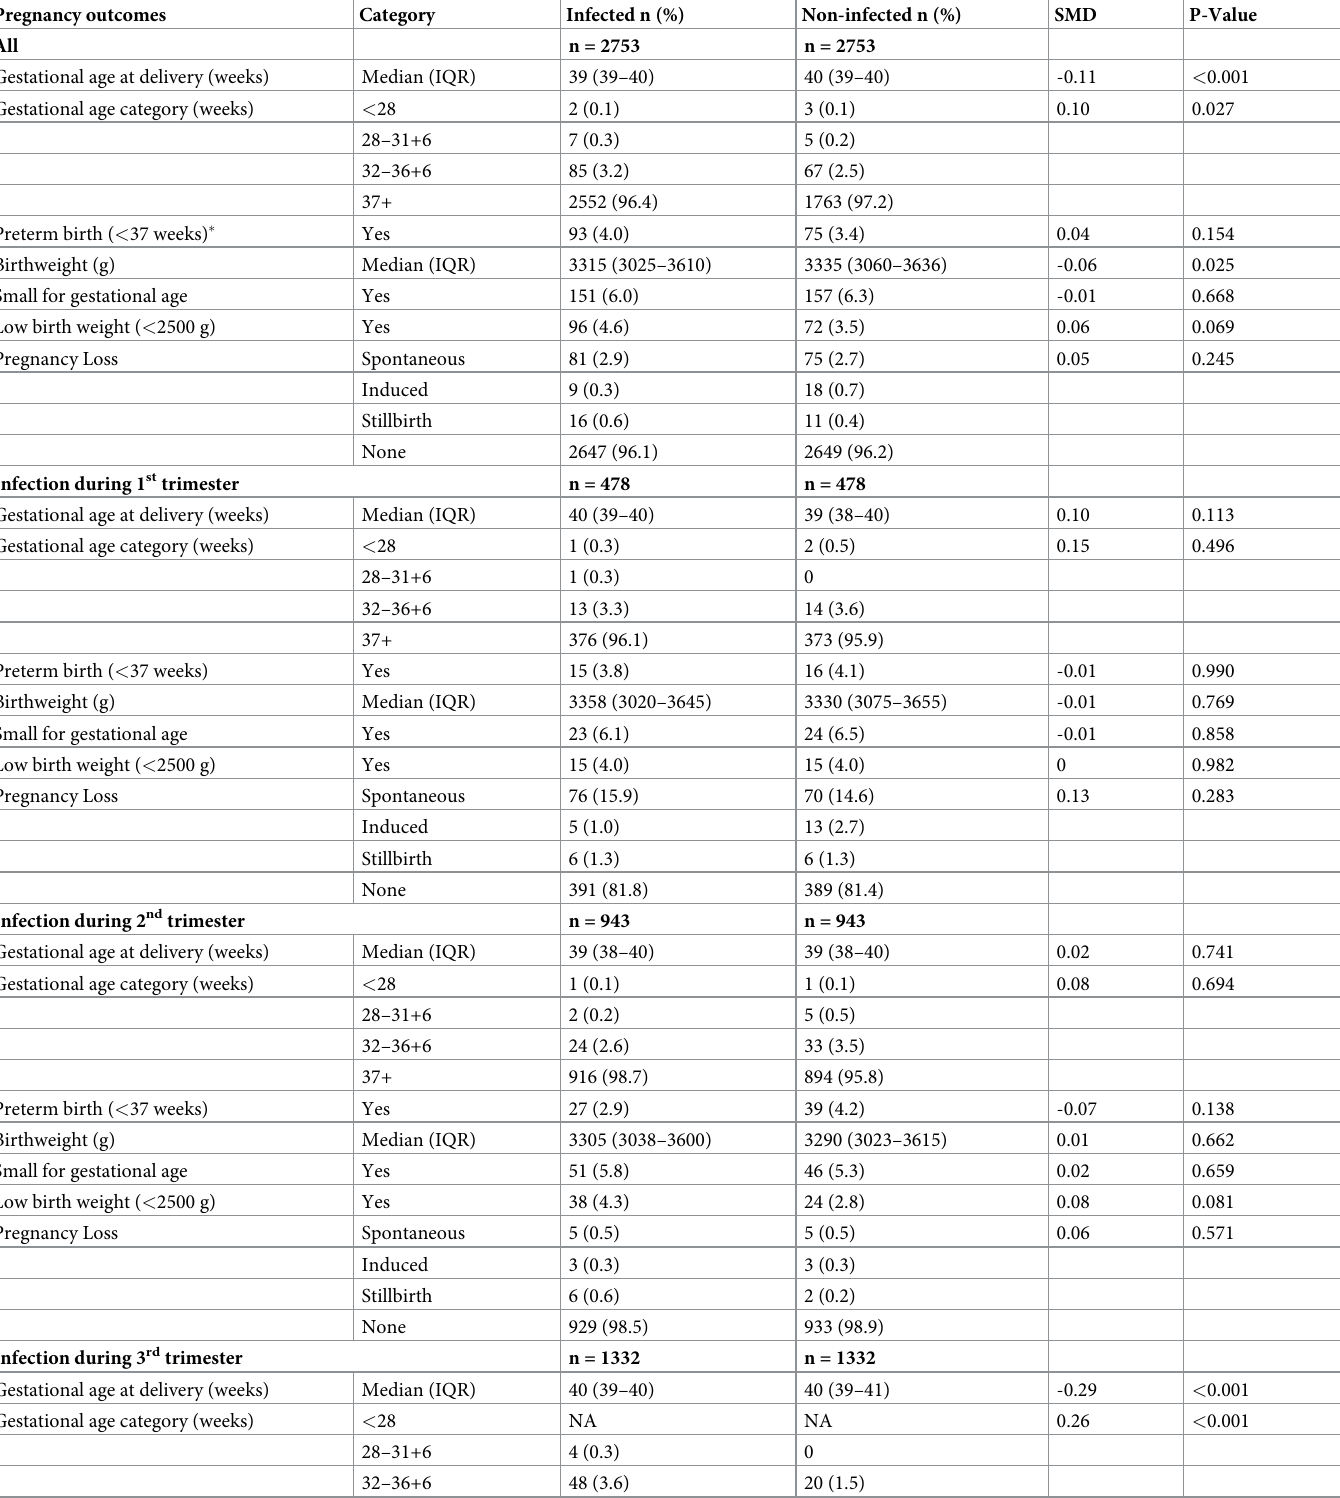
Table 2. Pregnancy outcomes by trimester at SARS-CoV-2